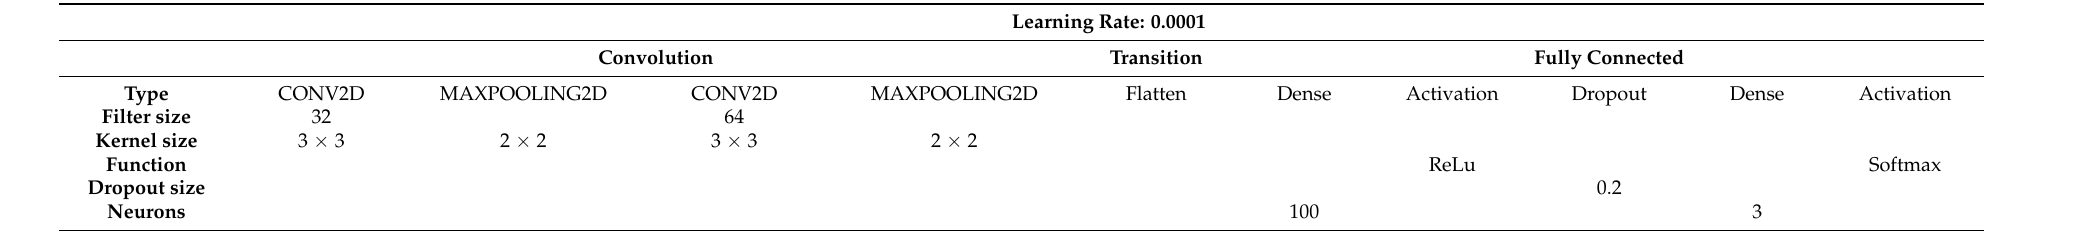
Table A1. Classification Level 1—Chair, Stair, Walk.